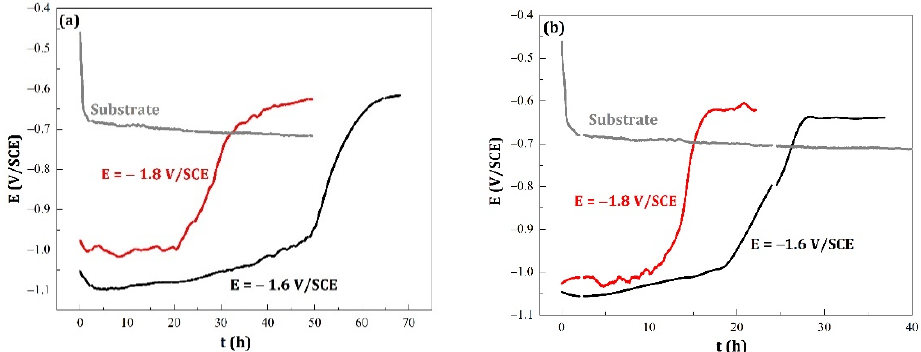
Figure 4. Evolution of corrosion potential in 3.5% NaCl solution versus time for carbon steel substrate and for Zn–Mn alloy coatings electrodeposited at ( a ) B = 0 T, ( b ) B = 0.3 T and at two imposed potential E = − 1.6 V/SCE and E = − 1.8 V/SCE.